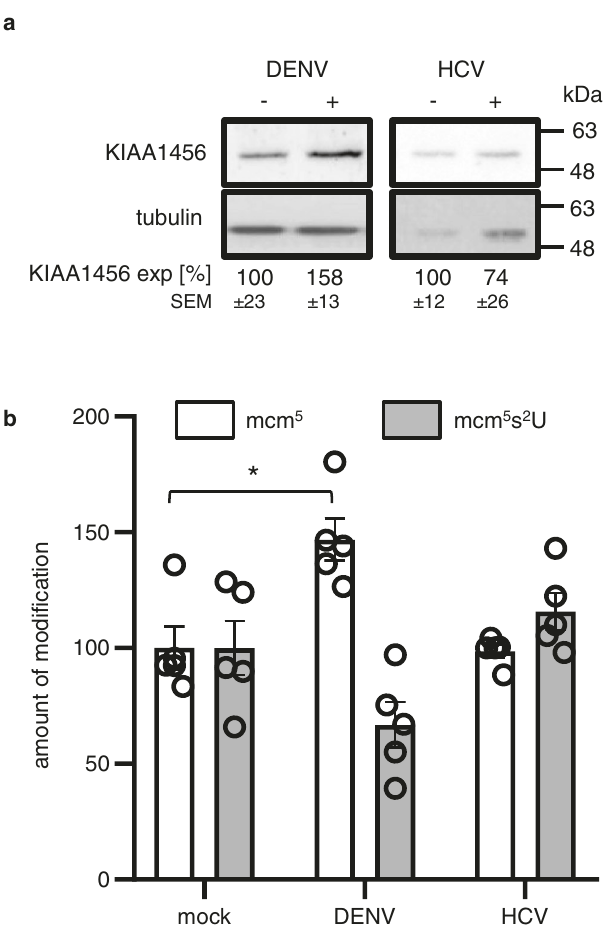
Fig. 6 Effect of DENV and HCV infection on KIAA1456 protein levels and mcm 5 and mcm 5 s 2 U levels. a Western blot showing KIAA1456 protein expression levels upon DENV and HCV infection. Values denote KIAA1456 expression normalized by tubulin expression relative to uninfected cells calculated from 3 independent replicates and expressed as mean ± SEM. b as in Fig. 5c but upon DENV and HCV infection. Bars represent the mean value ± SEM of 5 independent replicates ( p -value 0.007). Statistical analyses were performed using the two-tailed t -test. * p <